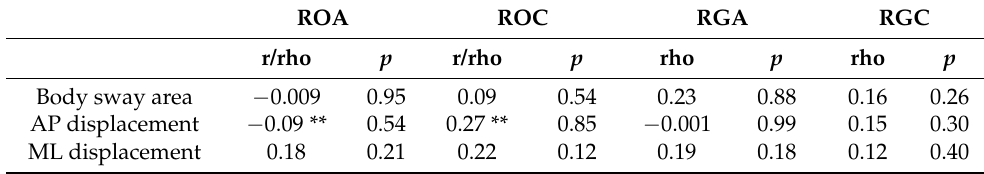
Table 3. Correlation between age and variables in each situation. ** Pearson coefficient (r). ROA ROC RGA RGC r/rho p r/rho p rho p rho p Body sway area − 0.009 0.95 AP displacement − 0.09 ** ML displacement